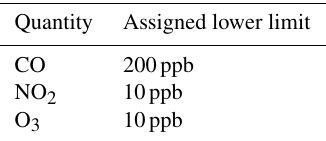
Table 1. Assigned lower limits for censoring small measurement values.